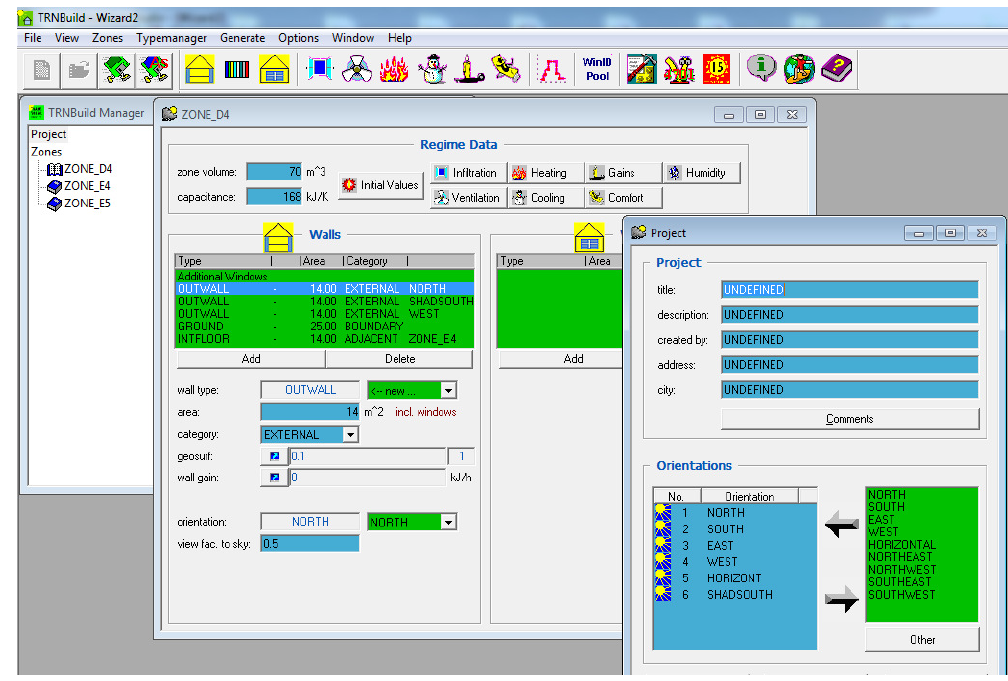
Figure 3. TRNsys model.